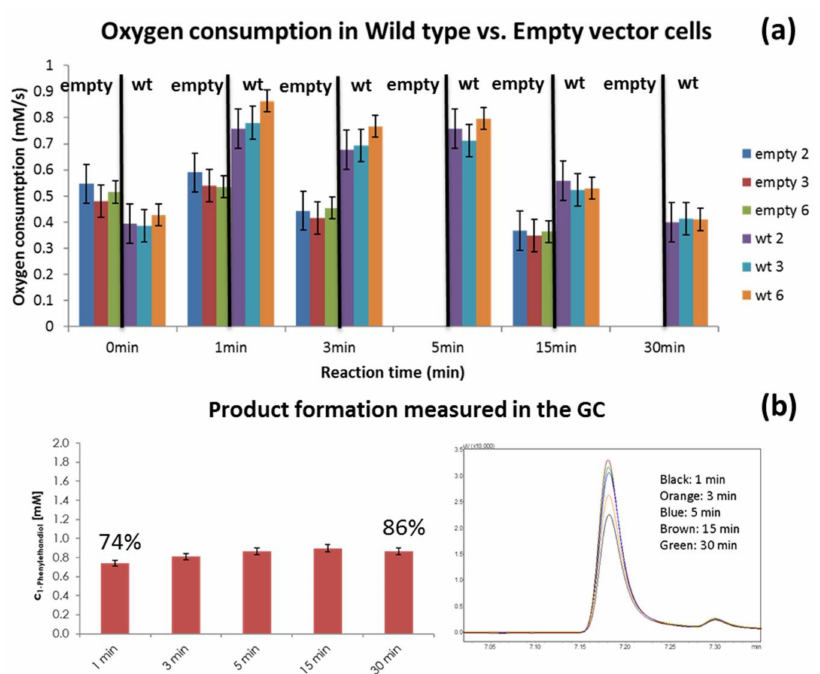
Figure 6. Oxygen measurements of the reaction of empty and wt cells in the presence of 1 mM styrene concentration ( a ); and corresponding GC results for the wt cells of 1-phenylethanediol concentration produced during the reaction and percentage of substrate conversion obtained at 1 and 30 min of residence time ( b